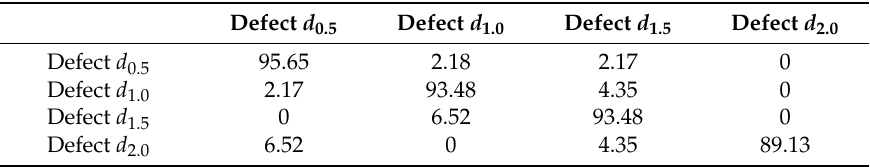
Table 7. Confusion matrix of the DCNN DEP after evaluation update procedure [%].